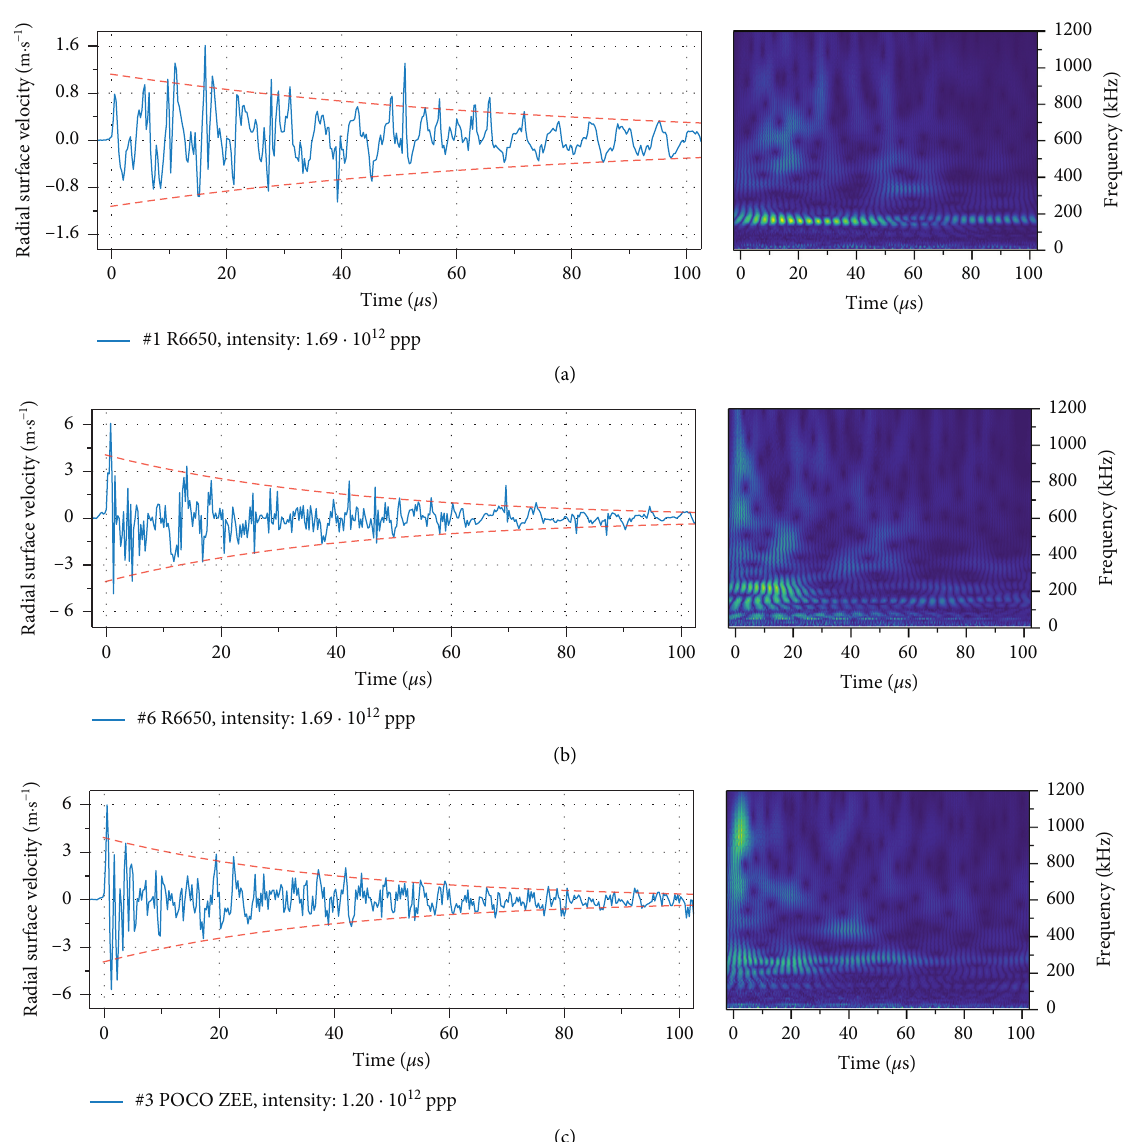
Figure 17: Radial surface velocity for maximum applied beam intensity on sample #1 R6650 (a), #6 R6650 (b), and #3 POCO ZEE (c). Left: recorded surface velocity (solid blue line) and calculated damping envelope (red dashed line). Right: continuous wavelet transformation as a function of time up to 100 μ s after beam